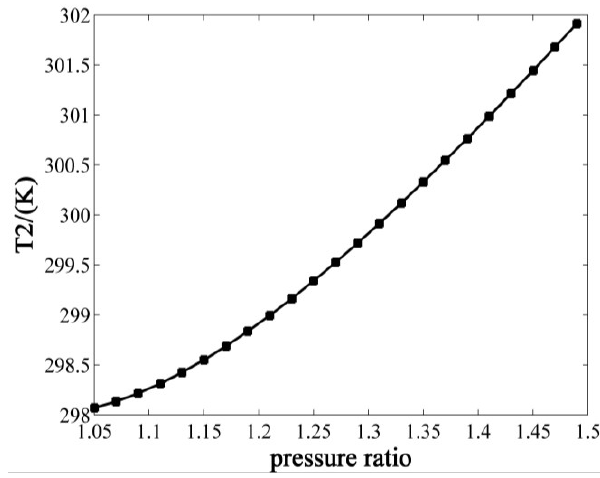
Figure 3. The variations in high pressure vessel temperature with pressure